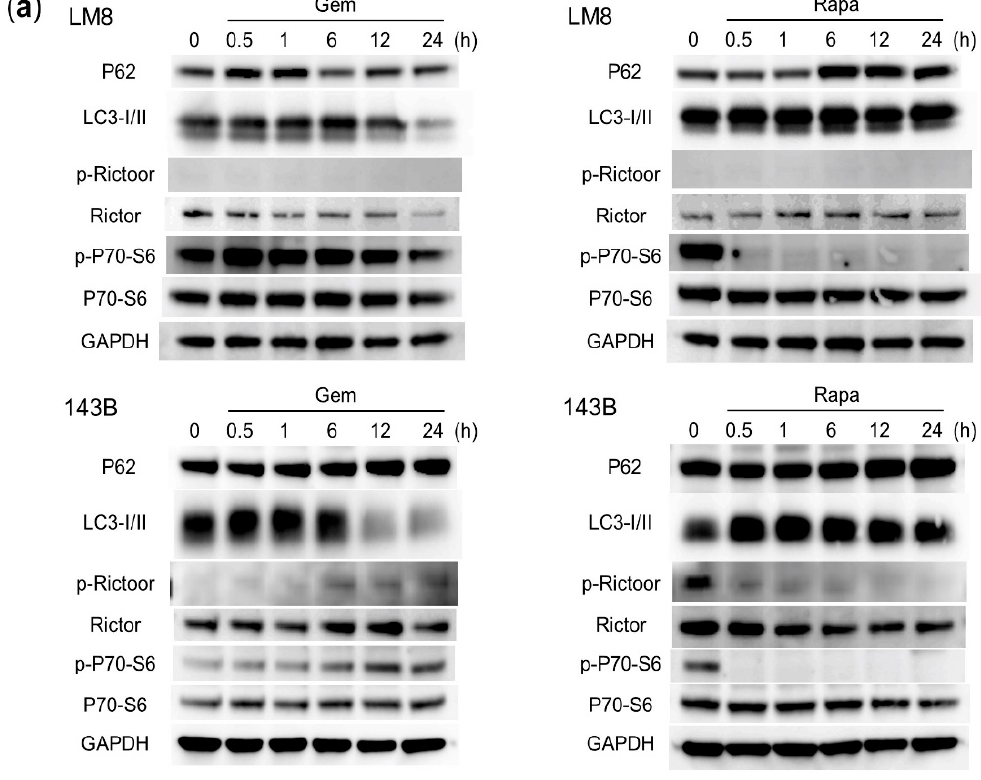
Figure 3. Rapa induced autophagy in OS cells. ( a ) LM8 and 143B cells were treated with Gem or Rapa and the levels of p62, microtubule-associated protein light chain 3 (LC3)-I/II, rapamycin-insensitive companion of mammalian target of rapamycin (RICTOR), and p70-S6 and their phosphorylated forms (as appropriate) were assessed by western blotting. See Supplementary Figures S5–S8 for examples of uncropped images and quantification the bands for each protein. ( b , c ) LM8 and 143B cells were loaded with Cyto-ID and treated with Gem alone or in combination with Rapa and analyzed by flow cytometry. Data are shown as the mean ± SD ( n = 3). * p < 0.05. MFI, median fluorescence intensity. N.S., not significant.